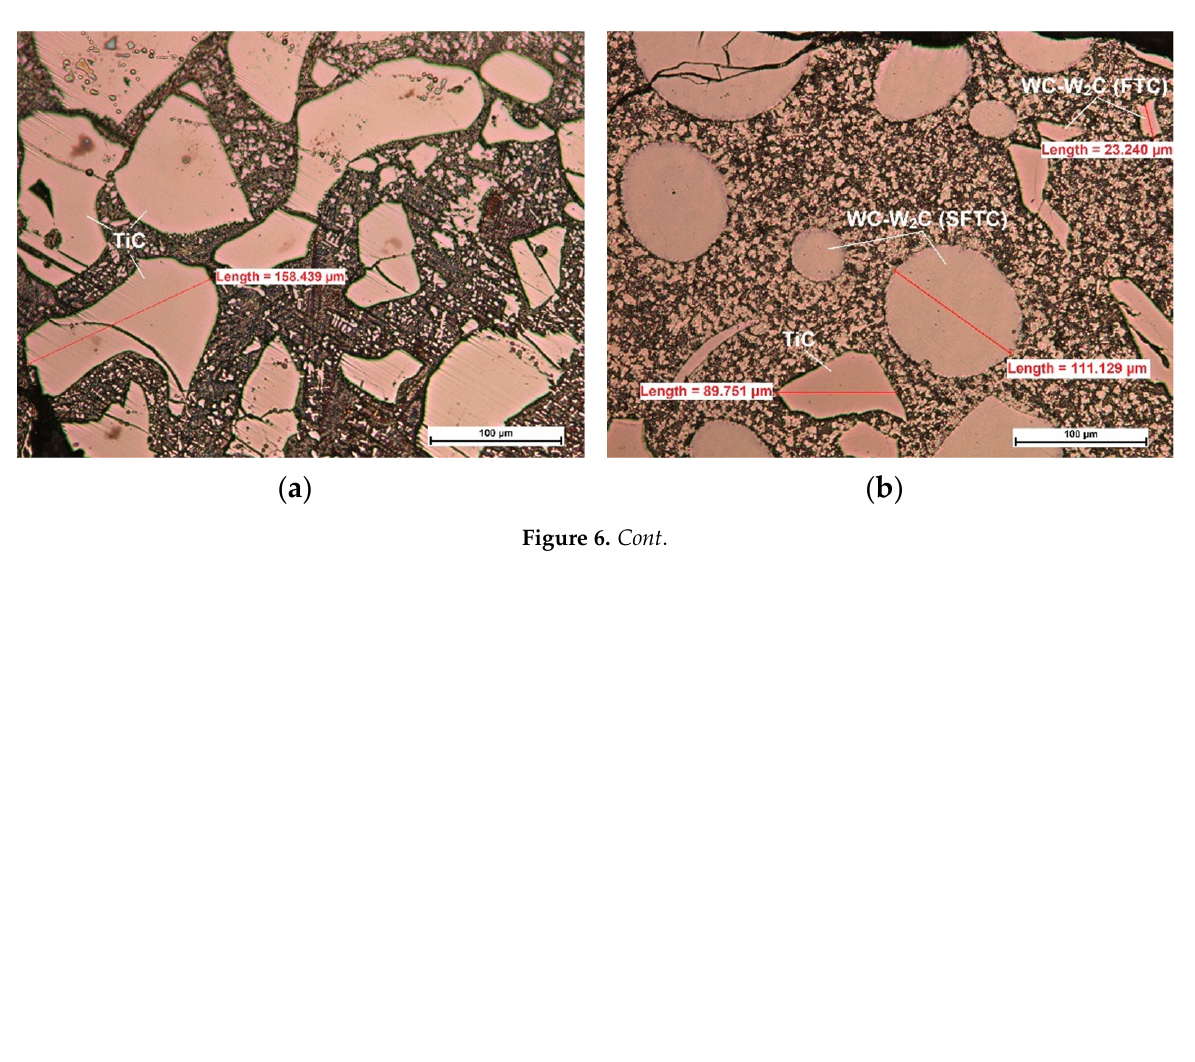
Figure 5. Exemplary macroscopic image of the longitudinal section of a composite surfacing weld: ( a ) C1 filler material; ( b ) C3 filler material.